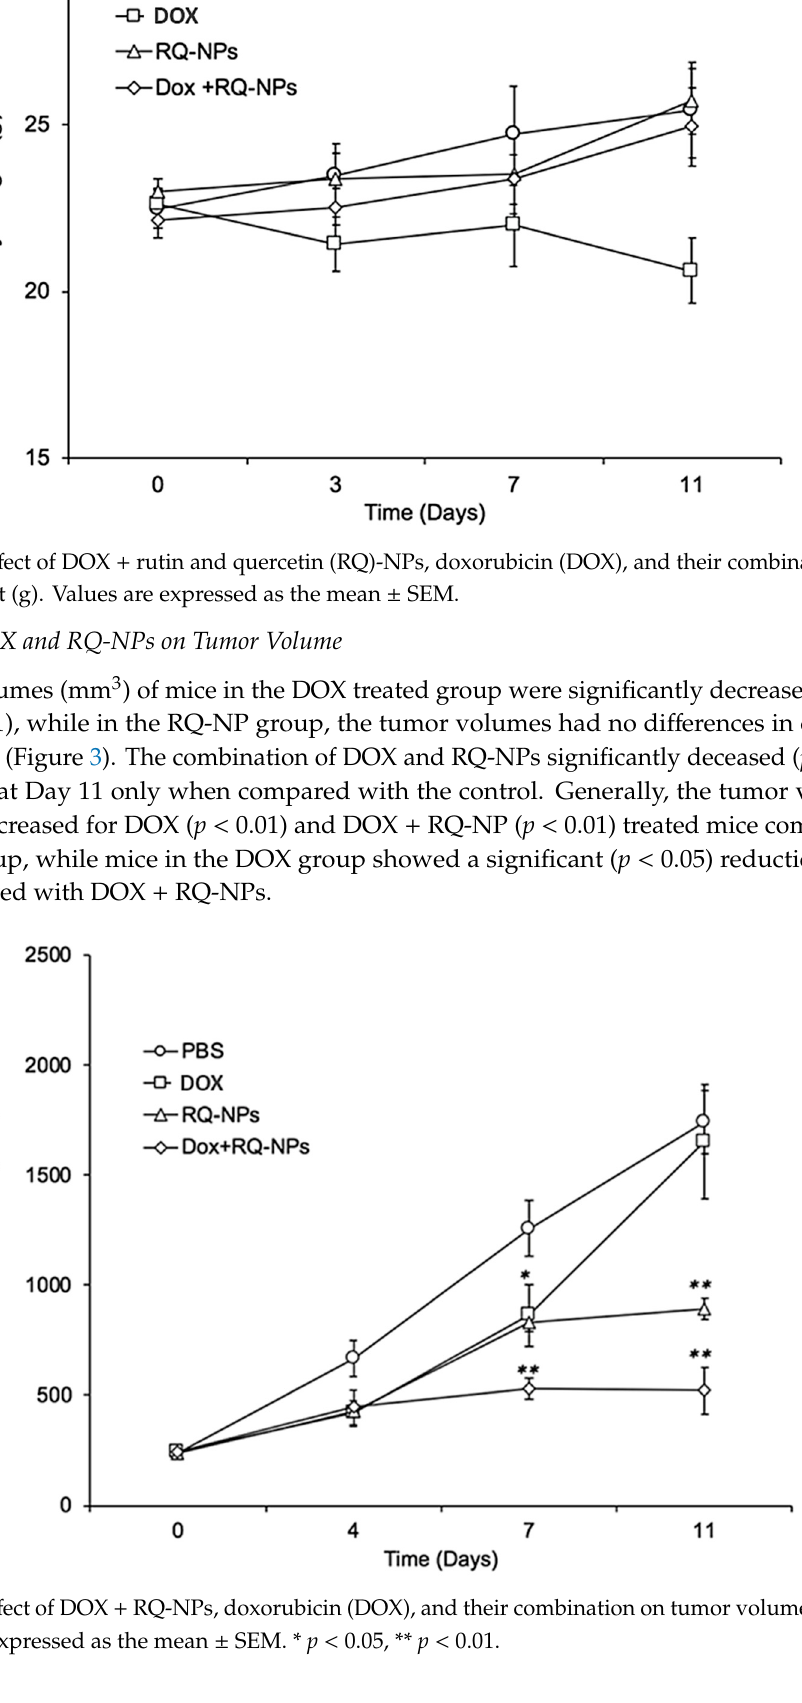
Figure 4. Effect of DOX + RQ-NPs, doxorubicin (DOX), and their combination on tumor weight (g). Values are expressed as the mean ± SEM. * p < 0.05, ** p < 0.01.